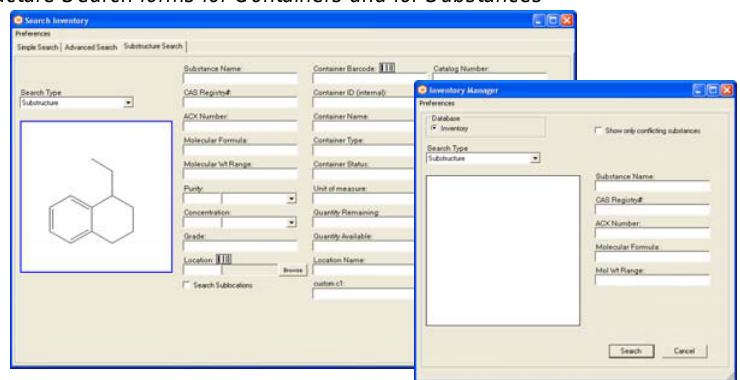
FIGURE 4: Substructure Search forms for Containers and for Substances